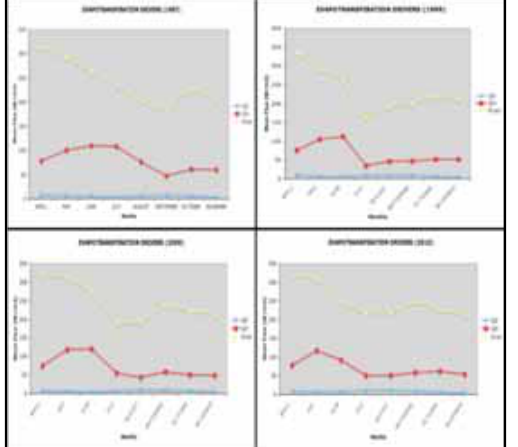
Figure 5. Monthly (averaged over the central India) net radiation (R n ) (W/m 2 ), latent heat flux (Q E ) (W/m 2 ) and sensible heat flux (Q H ) (W/m 2 ) for El Niño (1987,2009), La Niña (1999,2010) years.